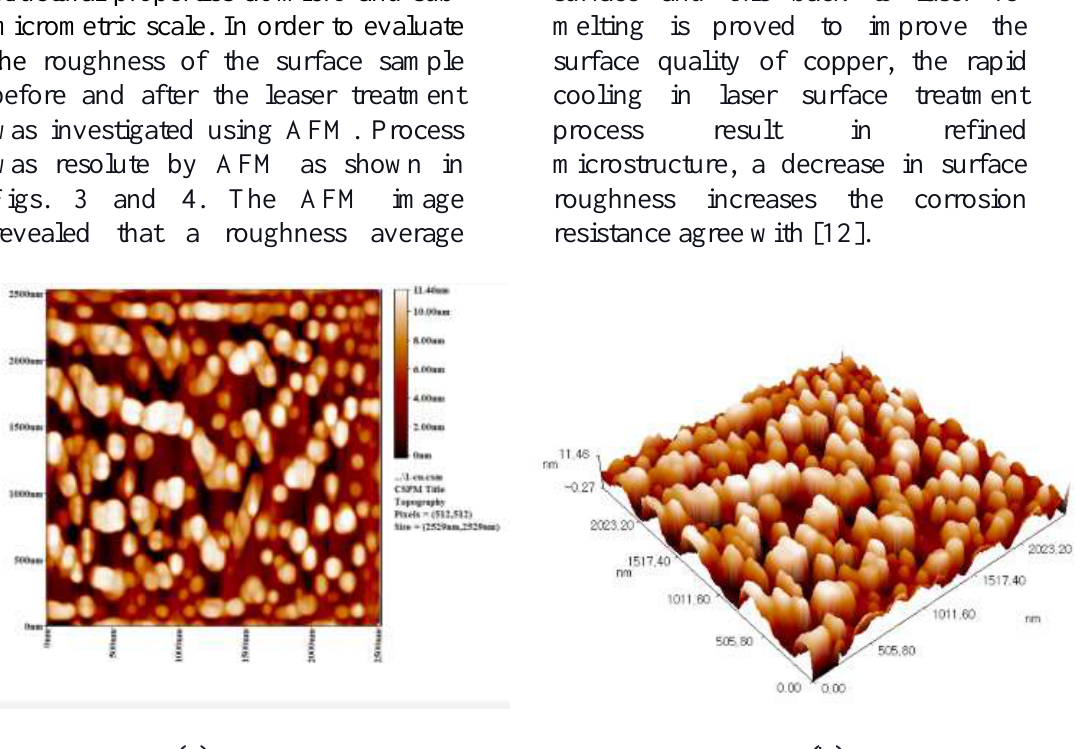
Fig.3: AFM Surface scans of copper surface before LST, a. (3D) View. b. (2D) View. Section analysis showing roughness 17